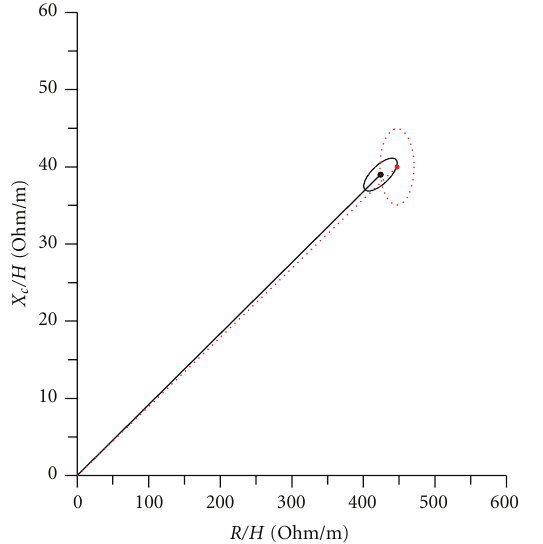
Figure 2: Mean vectors of 95% confidence limits in Taiwanese (red dotted line) and Polish (solid black line) college